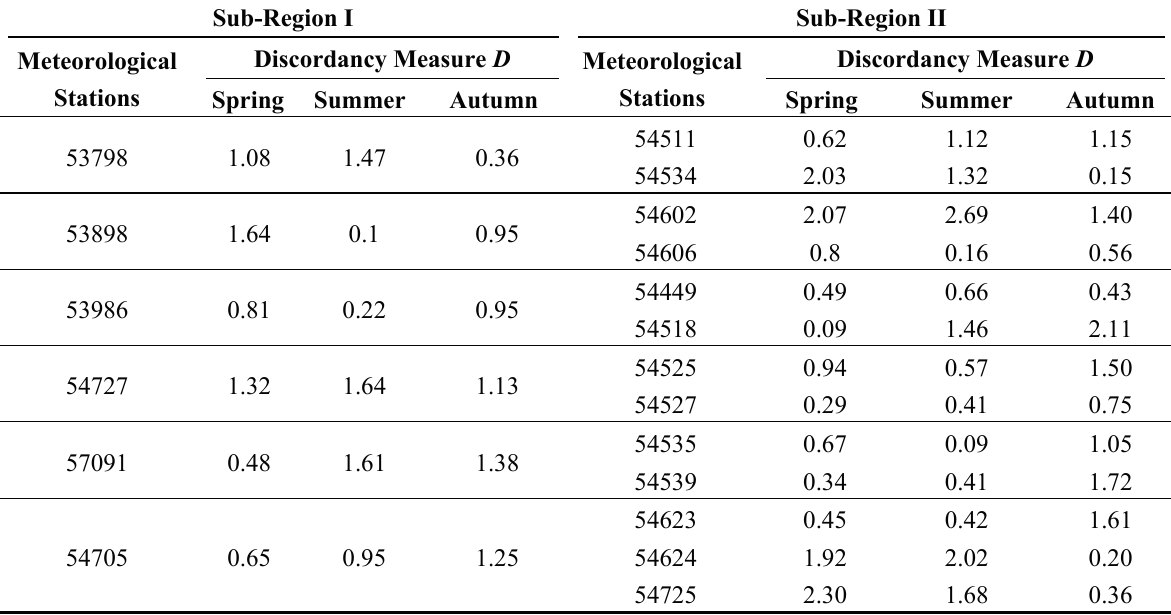
Table 4. Results of region-specific seasonal precipitation discordancy measure D .